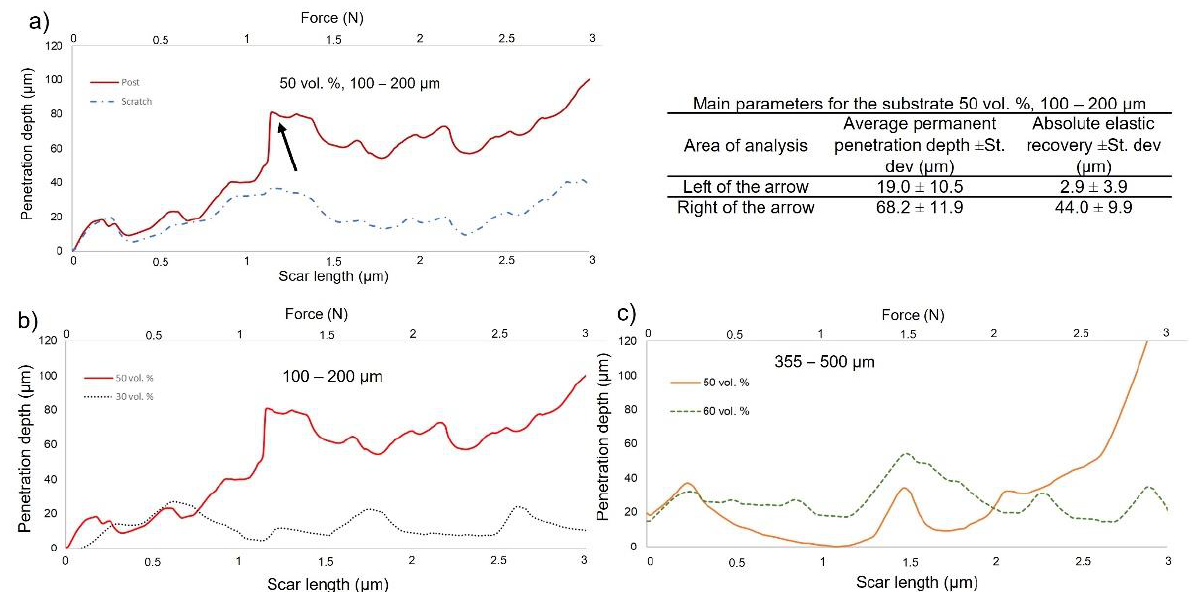
Figure 7. Penetration depth ( a ) during and after scratch tests for the c.p. Ti substrate with a pore range size of 100 – 200 µm and 50 vol.% porosity; ( b ) post scratch for 100 – 200 µm, 30 vol.% and 50 vol.% of porosity; and ( c ) post scratch for 355 – 500 µm, 50 vol.% and 60 vol.% of